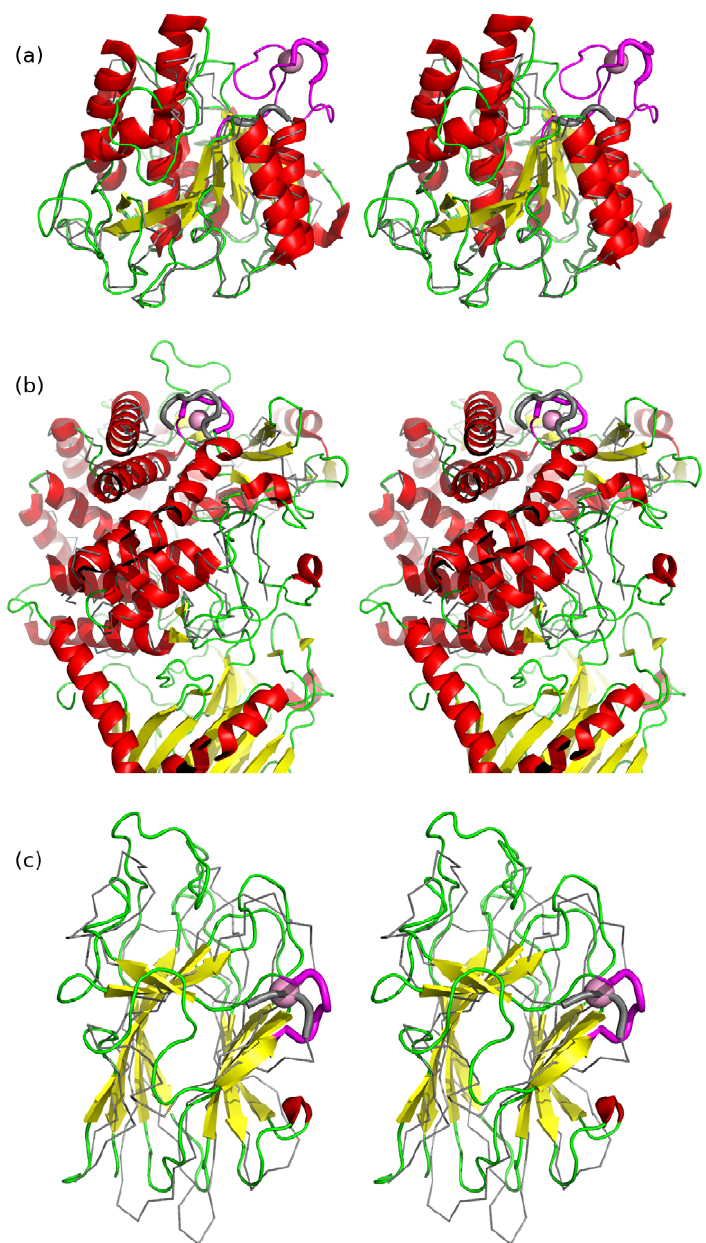
Figure 2. Stereo structure superpositions of novel Dx[DN]xDG calcium-binding motifs with nearest non-calcium binding structural neighbours. Panel a) shows T. kodakaraensis subtilisin (PDB code 2z2x), b) E. coli YgjK (PDB code 3c68) and c) the Porphyromonas adhesion domain (PDB code 3km5). In each case the Dx[DN]xDG motif is shown as a thick magenta cartoon with bound calcium in pink and the remainder of the calcium binding protein coloured by secondary structure. In a) the Dx[DN]xDG motif is positioned in a larger insertion binding four calcium ions which is also shown in magenta. Structural neighbours ( Bacillus lentus subtilisin (PDB code 1c9m) in a), a predicted hydrolase from Thermus thermophilus (PDB code 2z07) in b), and an adhesion domain from human Tyr phosphatase mu (PDB code 2v5y) in c) are in grey with the portion aligning to the calcium binding region shown as thick cartoon. Note that the fourth novel context (2zxq) has no non-calcium binding structural neighbour in the present